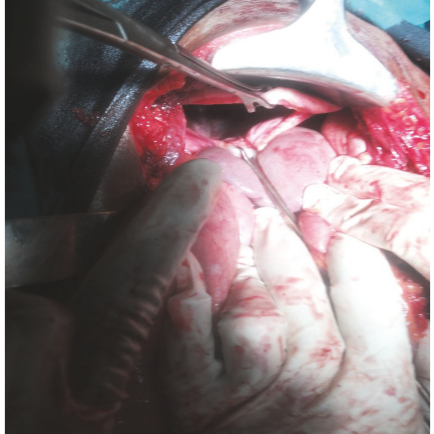
Figure 4: Operative finding of the diaphragmatic